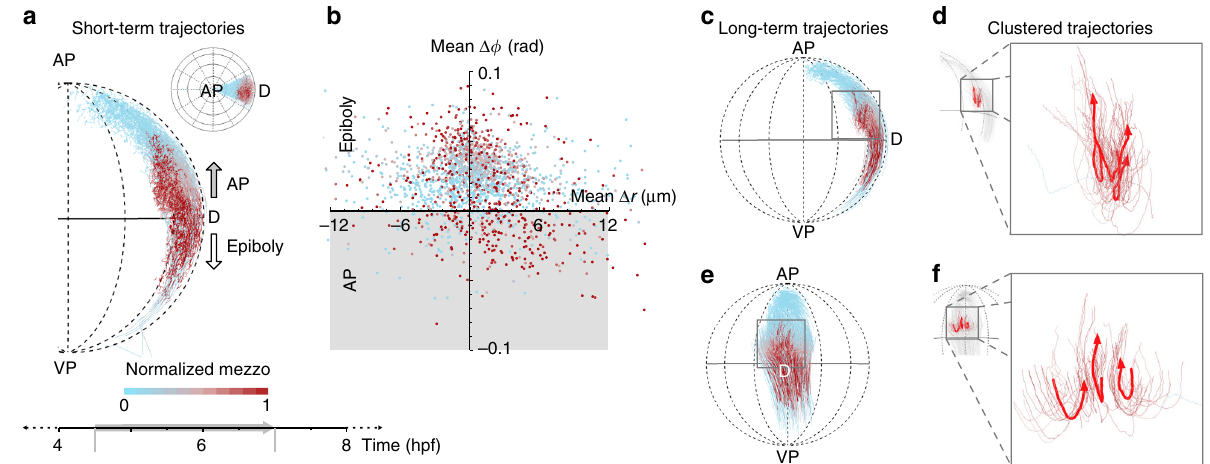
Fig. 3 Cell movements during internalization. a Lateral view of the embryo showing movement of a subset of cells around shield region (4.5 – 7 hpf; selected subset of tracks shown in inset from animal pole). Arrows indicate direction of epiboly and internalization movement towards the animal pole. Color code shows normalized level of mezzo expression along each track. b Scatterplot showing the average change in radius and latitude for each track during 4.5 – 7 hpf time interval. Gray region indicates cells moving towards animal pole. Color code shows normalized mezzo expression. c Lateral view of long-term cell fl ows around shield region. Same region-of-interest as in a . Color code indicates normalized mezzo expression along track. d Lateral view of three clustered cell tracks undergoing internalization and movement towards animal pole. Thick lines show the representative cluster centroid trajectories. Magni fi ed view of region indicated by box outline in a . e Dorsal view of long-term cell fl ows, same color code and region as in a . f Lateral view of the same clustered tracks and cluster centroids as in d embryo (Fig. 2g, i), indicating a position-dependent rather than a